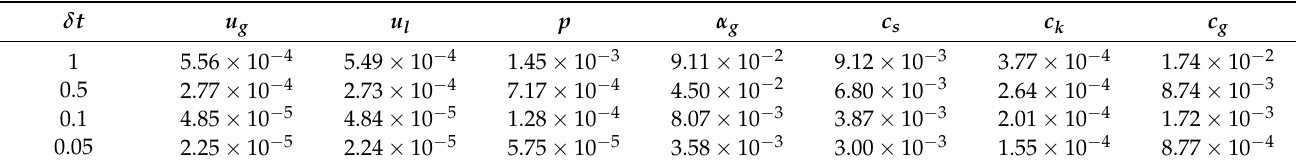
Figure 8. Convergence with respect to δ t for the case described in Section 5.2; log–log plot of the error for each unknown (note that the curves for u g and u l overlap). R.O.C. means “Rate Of Convergence”. The reference solution is a computation with a very small time step. Table 4. L 2 error with respect to the reference solution provided with time step δ t = 0.01, 50 × 10 uniform mesh, and α = 0.0005 for numerical simulation in Section 5.2 at T =